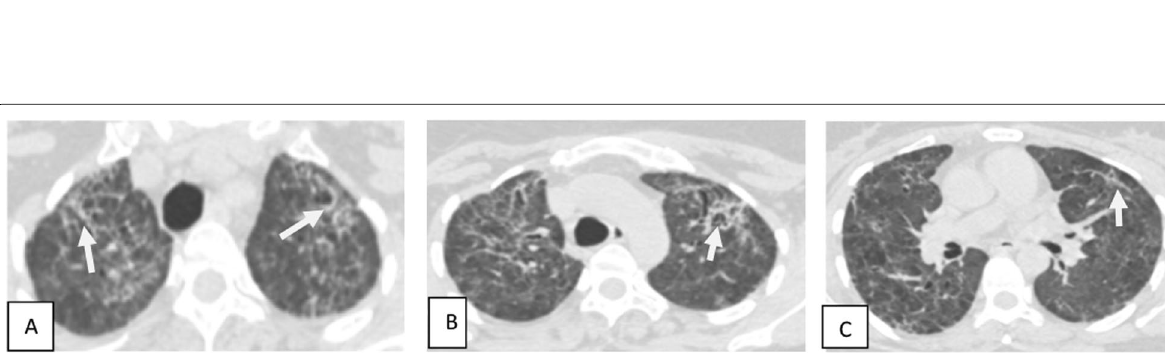
Fig. 6 Female patient aged 56 years old, with history of COVID‑19 infection 3 month ago, presented by dyspnea on exertion and tachypnea. Axial ( A – C ) CT cuts show bilateral diffuse interstitial thickening (white arrows) in the form of mild peri‑bronchial cuffing and mild interlobular